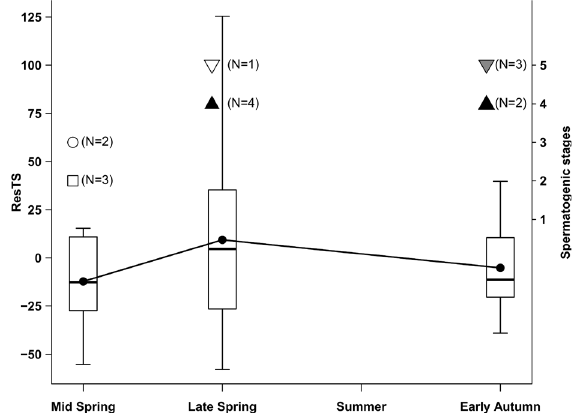
Figure 5. Seasonal variation of the residuals obtained from the lineal regression between snout-vent length and testicular volume (ResTS), and spermatogenic stages in the males of Phymaturus extrilidus . The plot shows the median (short-line) and the 50% of data in each season sample (box) and the whiskers are minimum and maximum values of the ResTS. Mean values of ResTS (black dots) are also represented. Spermatogenic stages found are: Stage 2 (spermatocyte, white square), Stage 3 (spermatide, empty circle), Stage 4 (spermiation, black triangle), Stage 5 (regression without spermatozoa in the epididymis: inverted empty triangle, and regression with spermatozoa in the epididymis: filled-gray inverted triangle). Sample sizes (N) are also